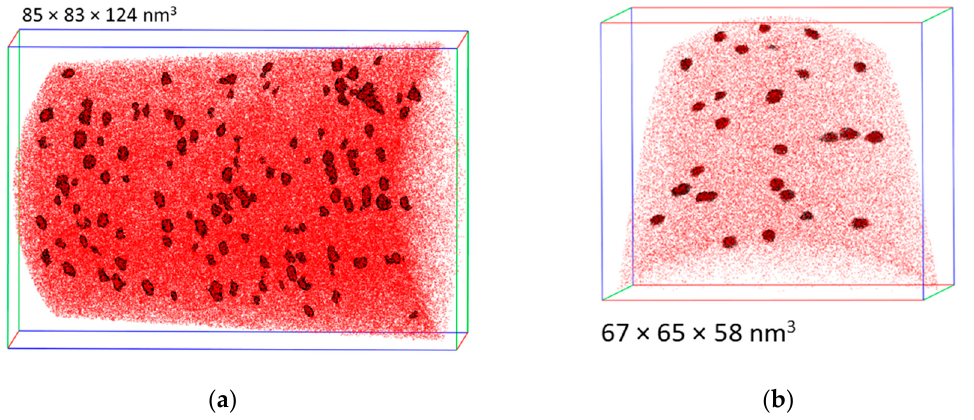
Figure 6. APT solute atom map for the RPV weld, ( a ) high-flux condition (WH), ( b ) low-flux condition (WL). Cu, Ni and Si atoms are represented in red. Clusters are highlighted using thresholds of 5.6 and 5 at% for WH and WL, respectively.